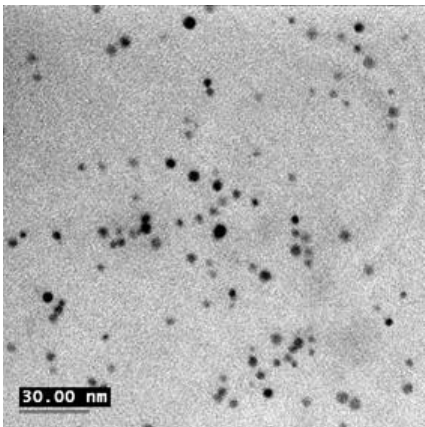
Figure 2. TEM image of Au-SPh nanoparticles; scale bar 30 nm.